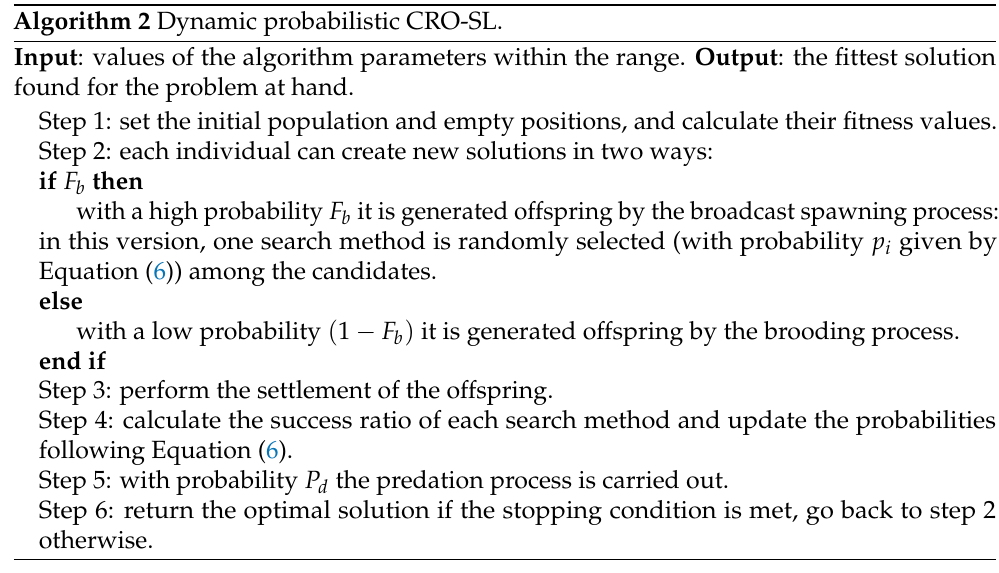
Figure 3. Outline of the dynamic probabilistic CRO-SL algorithm (DPCRO-SL). To ensure that the space of operators is effectively explored, a probability threshold is set, ε , so that all substrates have at least a probability ε of being assigned to an individual. This probability can be very small but must be enough to ensure that the operator will eventually be chosen. Algorithm 2 shows the pseudo-code of the DPCRO-SL version. Algorithm 2 Dynamic probabilistic